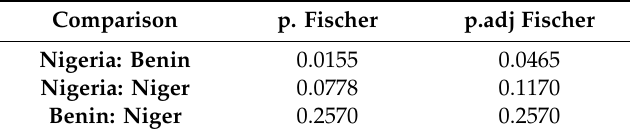
Table 14. Comparing results across the three